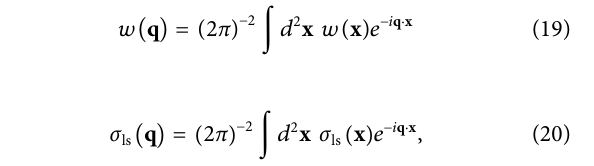
Frontiers in Mechanical Engineering |